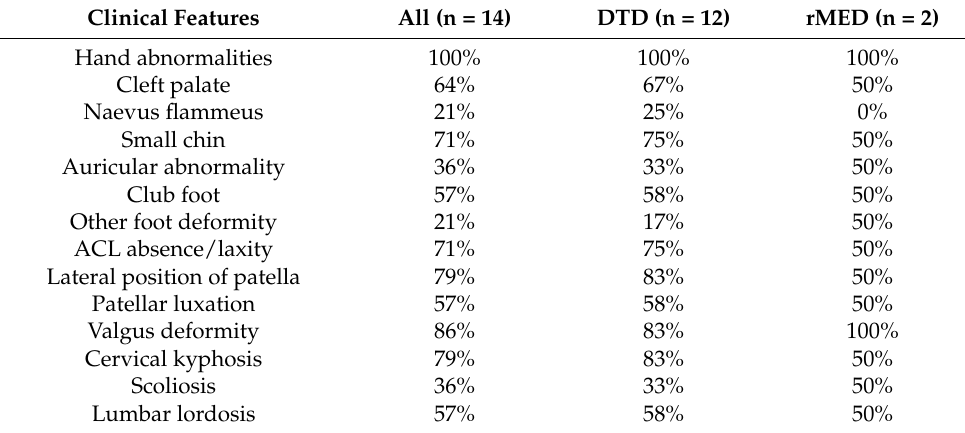
Table 3. Prevalence of clinical features in the Finnish children with SLC26A2 -related skeletal dysplasia. Values are given for the whole cohort and separately for children with DTD and